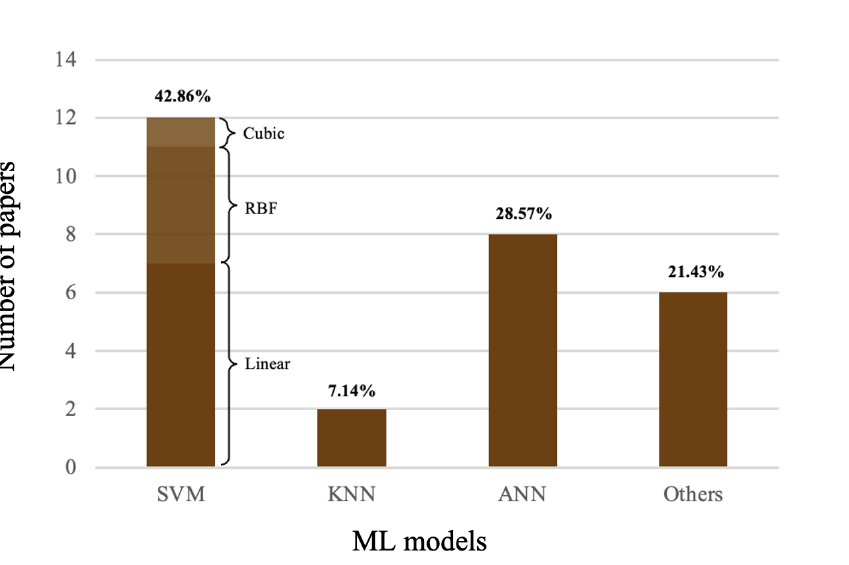
Figure 5. Analysis of the most used ML models. The “others” category includes the random forest, linear discriminant analysis, naive Bayes, RUSBoost, and XGBoost